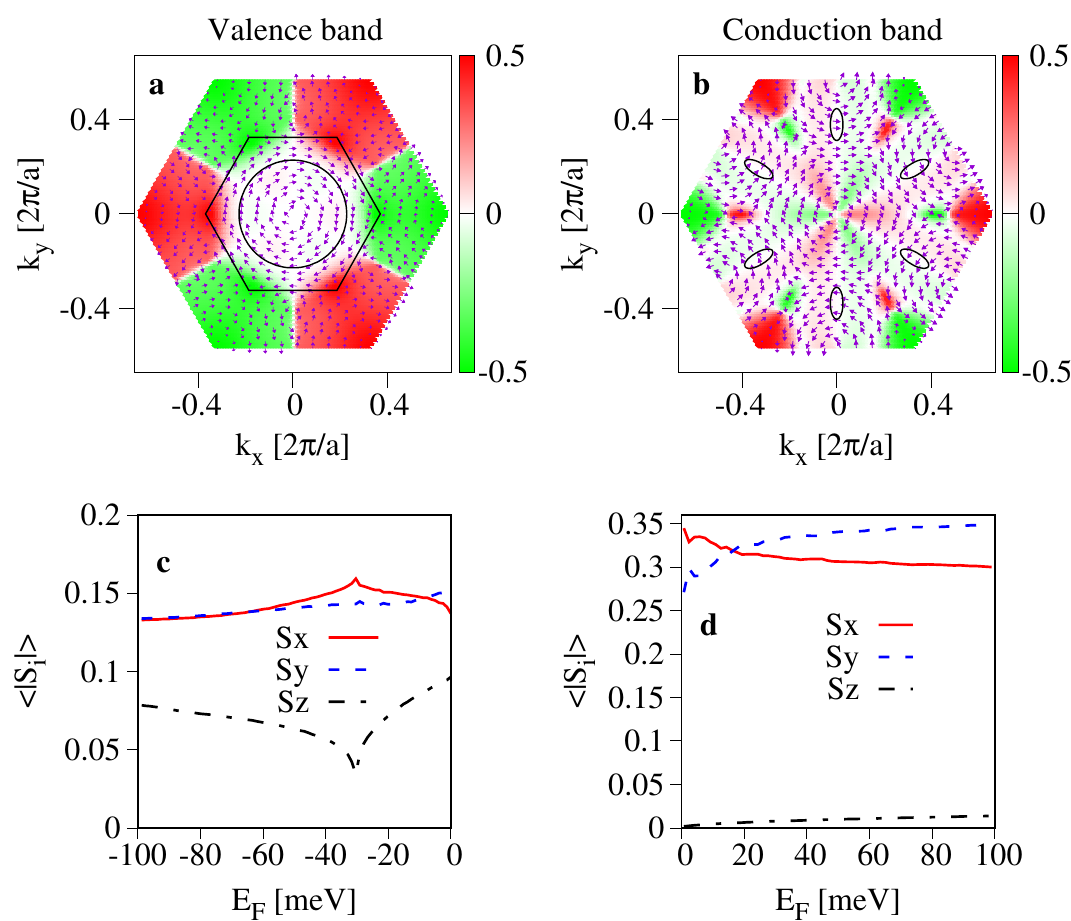
Figure 5. Effects of the extrinsic SOC on the electron spin: ( a ) the induced in-plane spin texture (arrows) and s z component of spin (color) for the top-most valence band and the electric field E = 1 Vnm; ( c ) The corresponding Fermi surface averaged spin expectation values versus doping. The BZ wedge corresponding to doping in the range 0–100 meV is given by the area limited by the black hexagon and circle; ( b , d ) same as ( a , c ) but for the conduction